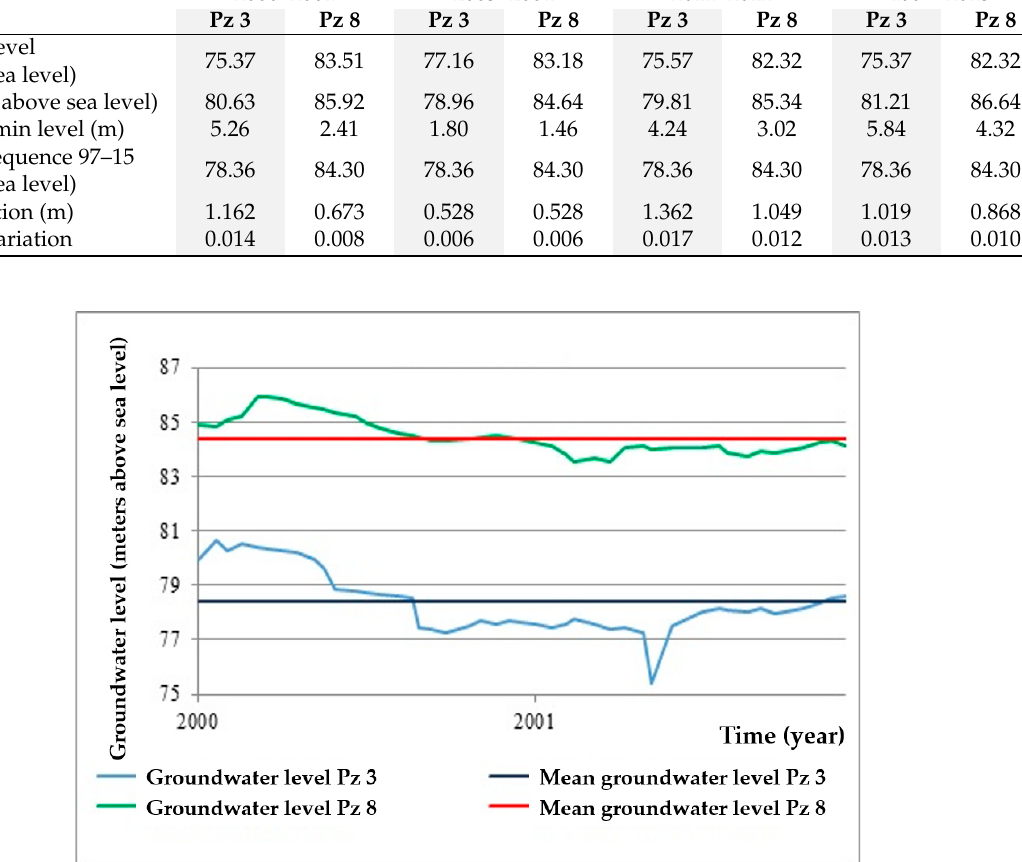
Figure 10. Fluctuations of groundwater levels Pz 3 and Pz 8 during 2000 and 2001.